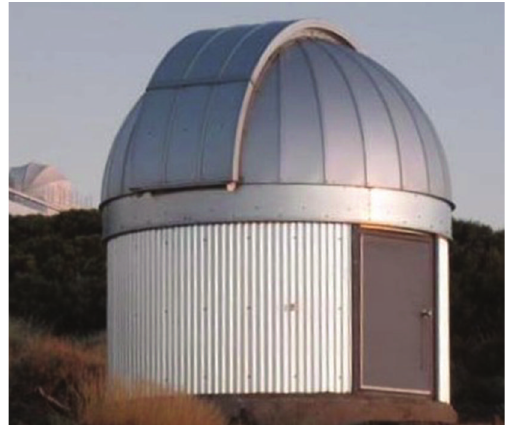
Figure 2: Earthshine dome in the Canaries. Part of the German Gregor dome may be seen in the